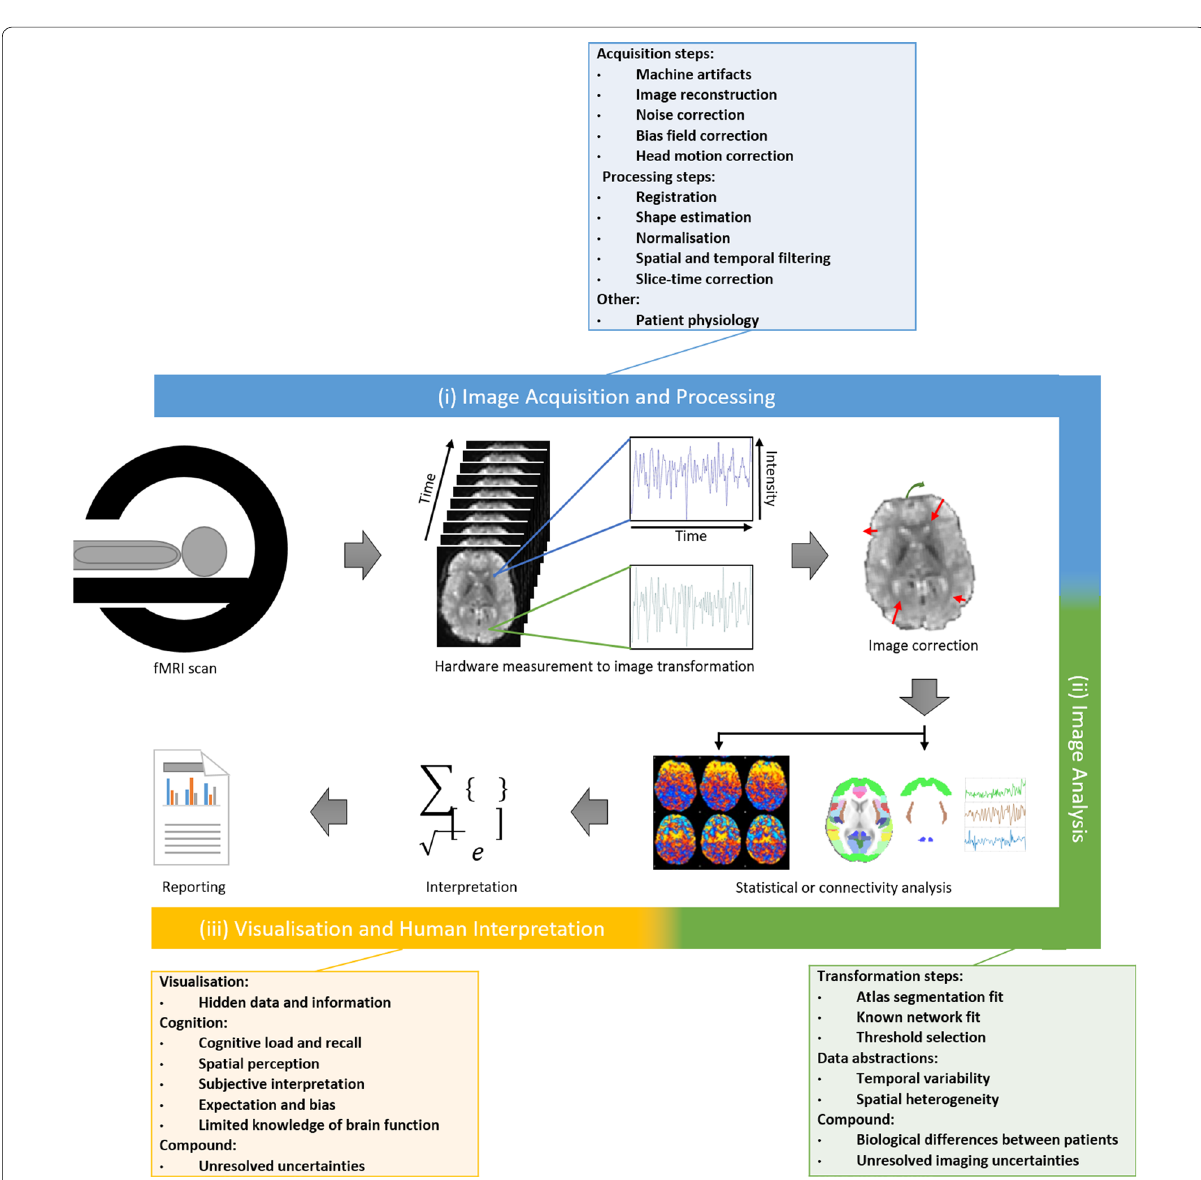
Fig. 1 Summary of the fMRI image analysis pipeline, categorised into three phases: (i) image acquisition and processing; (ii) image analysis; and (iii) visualisation and human interpretation. Each of the three phases comprises multiple processing steps that introduce new uncertainties and compound upon existing uncertainties. A summary of the main steps in each phase is denoted in the three